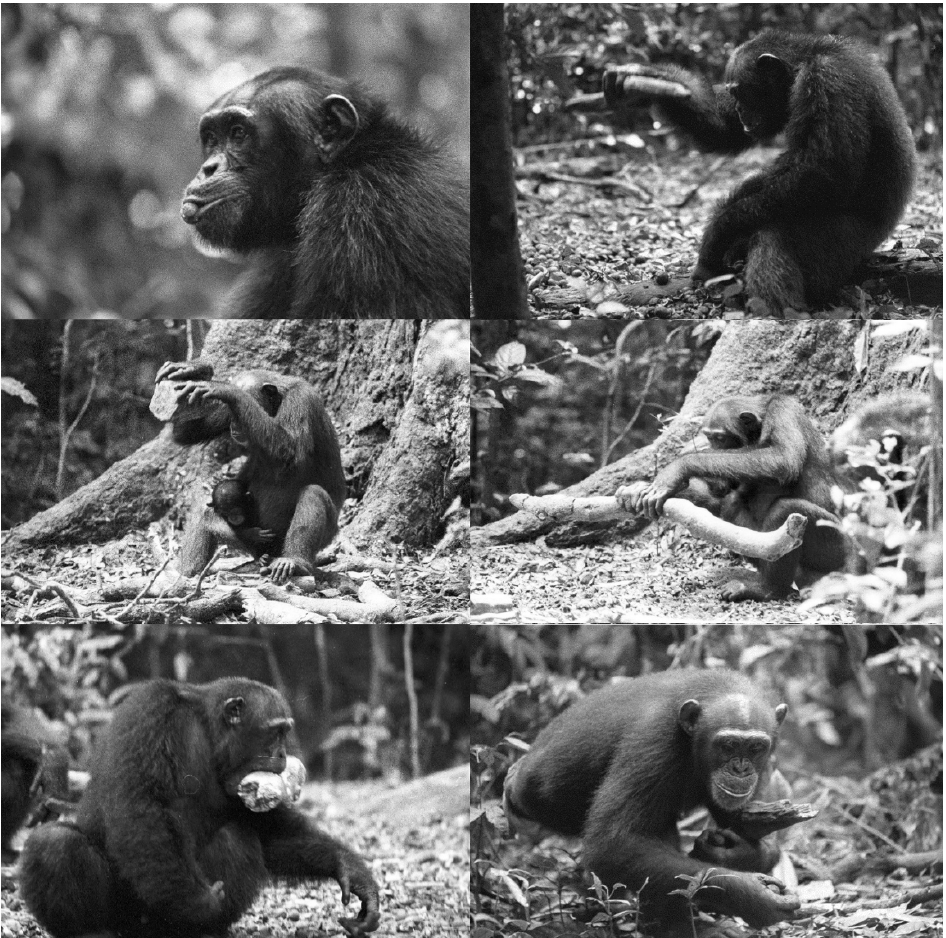
Taï Chimpanzees Cracking Nuts with Natural